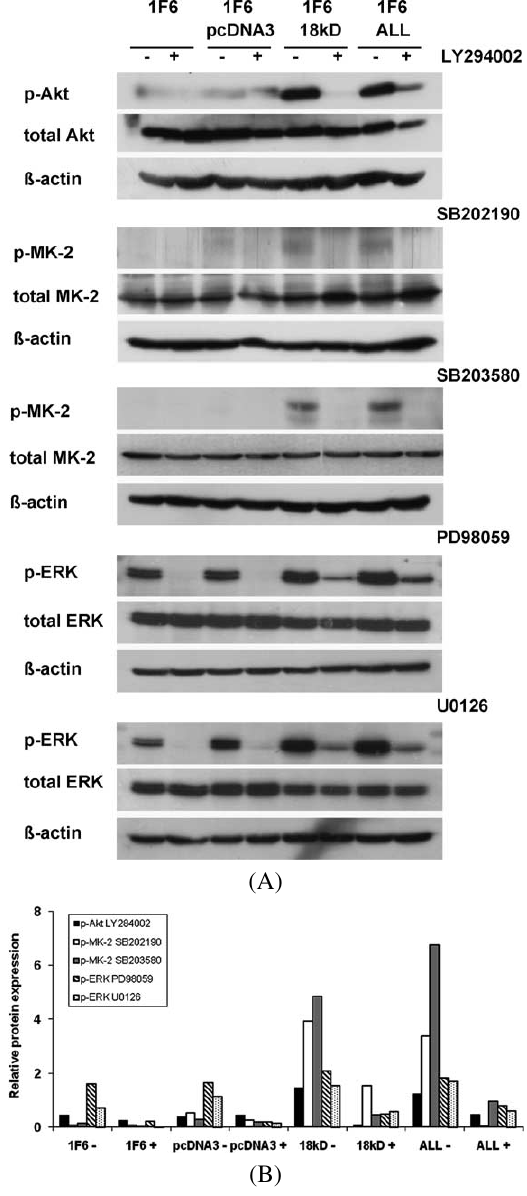
Fig. 6. Efficiency of PI-3K, p38 and ERK1/2 inhibition. 1F6 par- ent cells, 1F6-pcDNA3, 1F6-18kD and 1F6-ALL clones were in- cubated in serum-free medium for 24 h in the absence or pres- ence of 40 µM LY294002, 10 µM SB202190, 10 µM SB203580, 50 µM PD98059 or 10 µM U0126. (A) Inhibition of PI-3K, p38 and ERK1/2 was determined by Western blots for the downstream targets, p-Akt, p-MAPKAPK-2 (p-MK-2) and p-ERK1/2, respec- tively. Blots were stripped and re-probed with antibodies against to- tal Akt, MAPKAPK-2 (MK-2) and ERK1/2. As a loading control, blots were probed for β -actin. (B) Quantification of band intensi- ties of phosphorylated proteins when normalized to their respective β -actin loading controls.